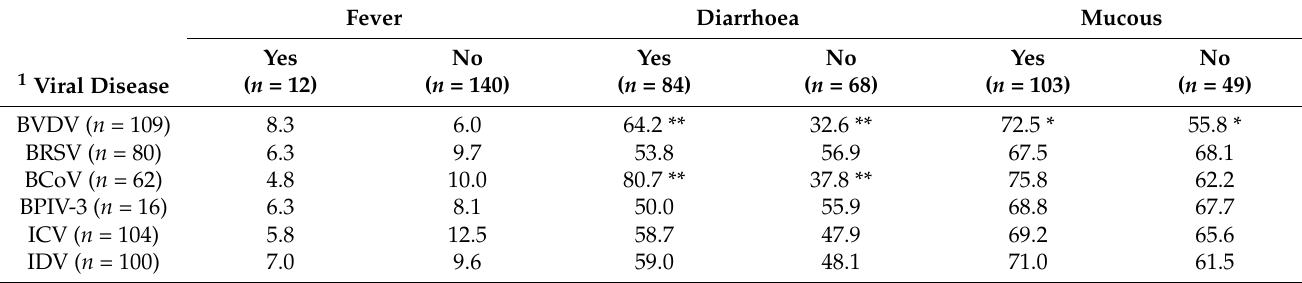
Table 2. Comparison of percentages of signs in the viral disease of bovine respiratory disease (BRD) calves, the <1-year calves with respiratory syndromes. * and ** indicate a difference between with (Yes) and without the disease (No) at p < 0.1 and p < 0.05,